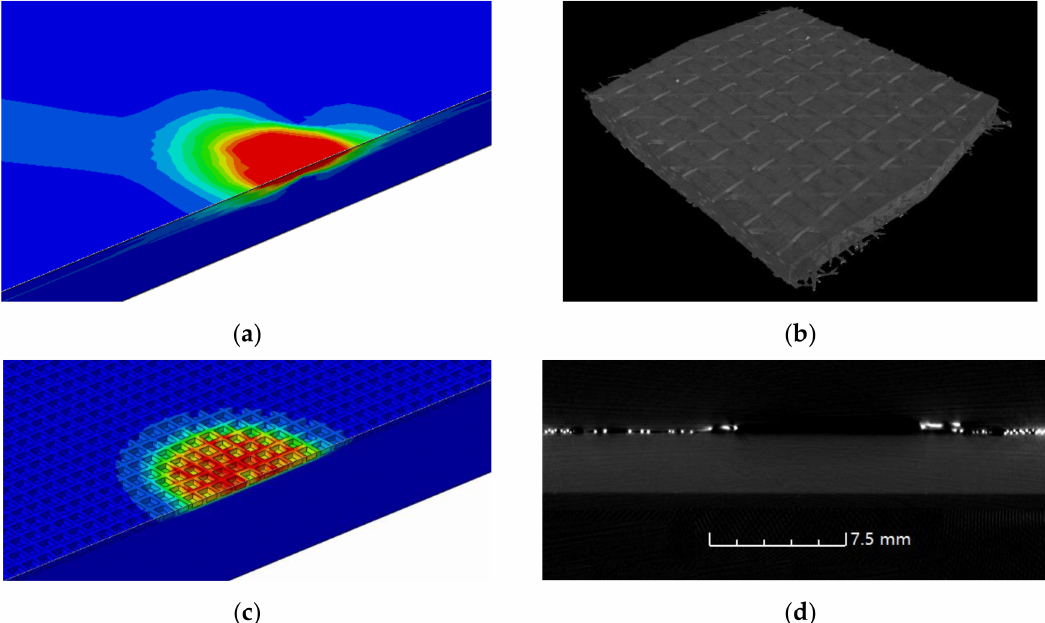
Figure 5. Ablation damage images of FEA models and computerized tomography (CT): ( a ) the temperature field of FEA model of A20; ( b ) 3D reconstruction based on CT of A20; ( c ) the temperature field of FEA model of B60; ( d ) the industrial CT image of